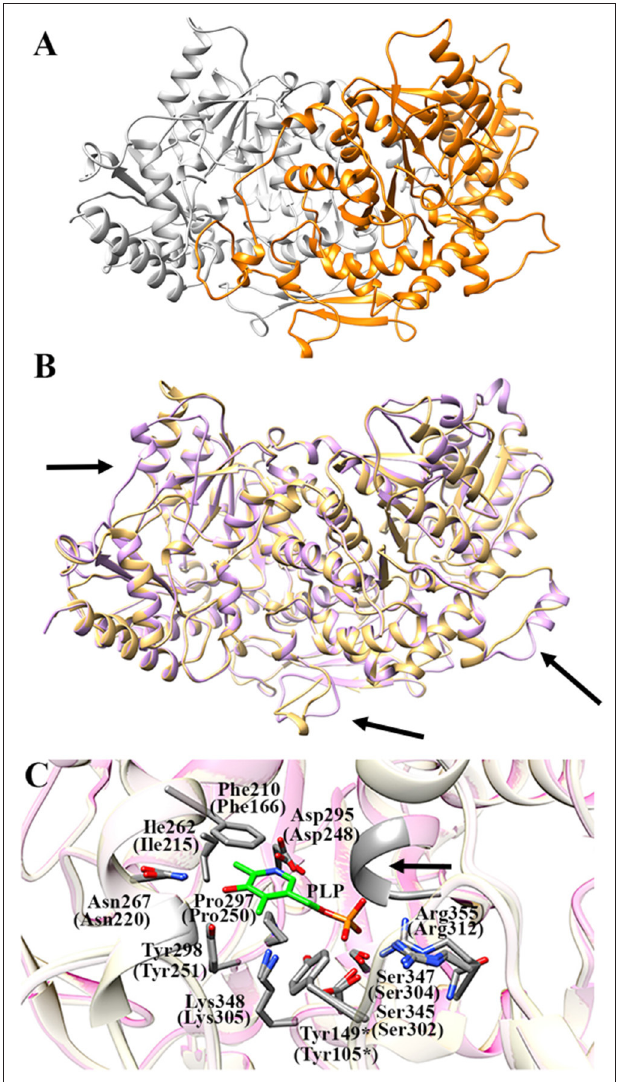
FIGURE 7 | AroH homology model . (A) Homology model of dimeric AroH as ribbon representation obtained using the SWISS-MODEL portal. The two monomers are colored orange and white. (B) Superimposition between the structure of Aro8 (light purple) and that modeled for AroH (light orange). Flexible regions are indicated with arrows. (C) Active site topology of superimposed AroH and Aro8 structures. Residues involved in PLP binding are represented as gray sticks. The PLP cofactor is represented as green stick. The arrow indicates the position of the main-chain of Ser185 and Asn186. Tyr149* belongs to the neighboring subunit. Numbers under parentheses indicate residue position in Aro8.